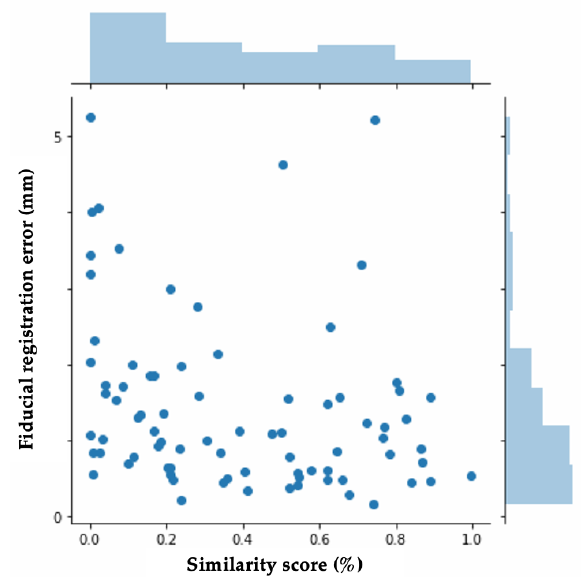
Figure 9. FRE and Similarity score Figure 9 . FRE and Similarity score distribution.